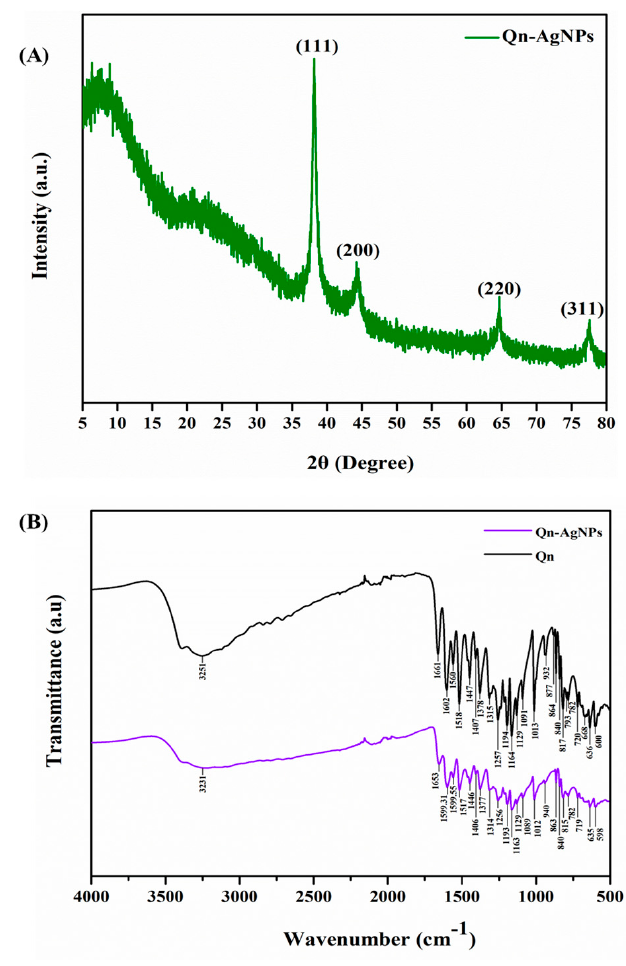
Figure 4. The XRD spectrum of quercetin mediated synthesized silver nanoparticles (Qn-AgNPs) ( A ) and FTIR spectrum of Qn and Qn-AgNPs ( B ).